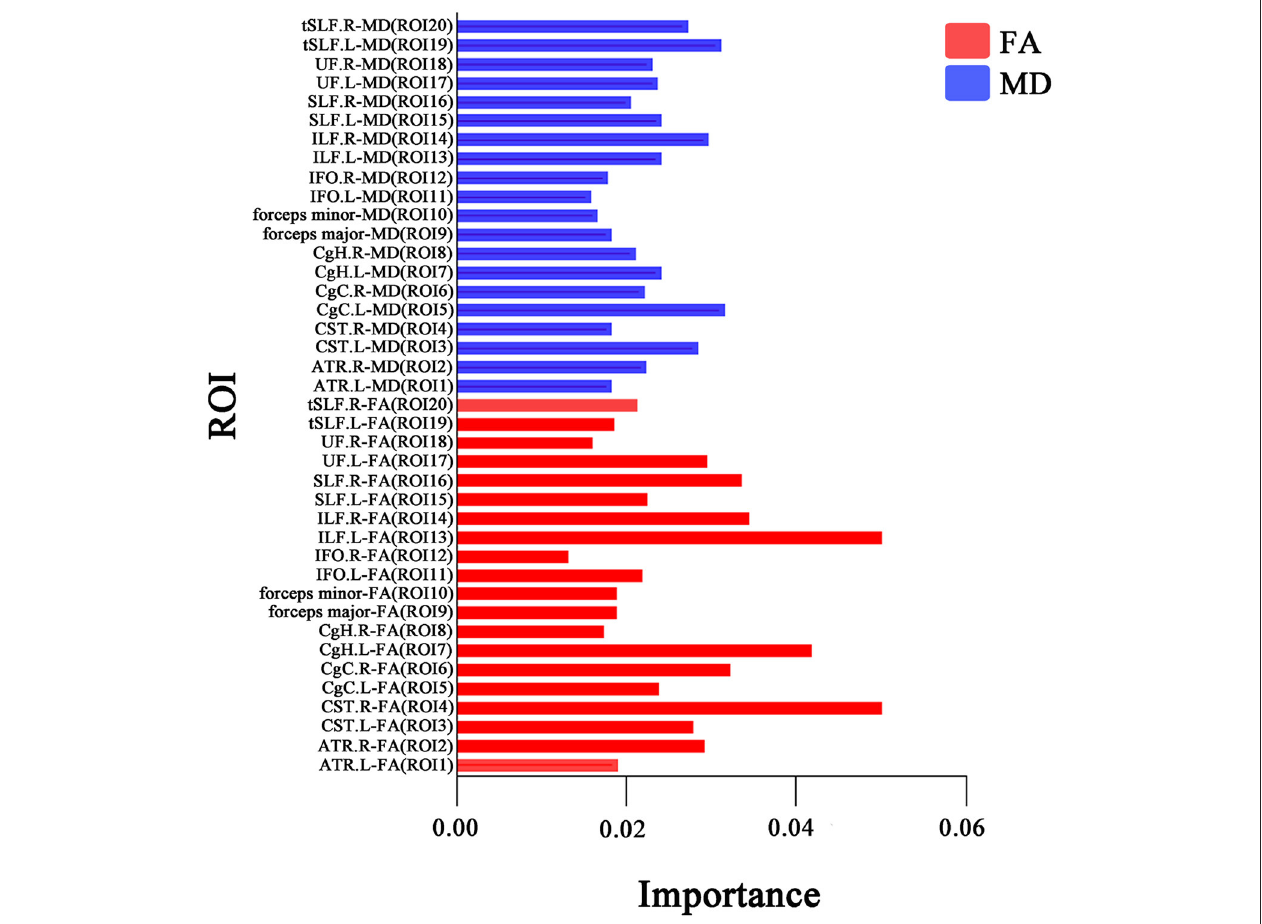
FIGURE 3 | The importance index of the FA (red color) and MD (blue color) values of all white matter ROIs. The longer column represents higher importance. The most important features are the FA in the ILF.L (ROI = 13). ROI, region of interest; ILF, inferior longitudinal fasciculus; FA, fractional anisotropy; MD, mean diffusivity; R, right; L,